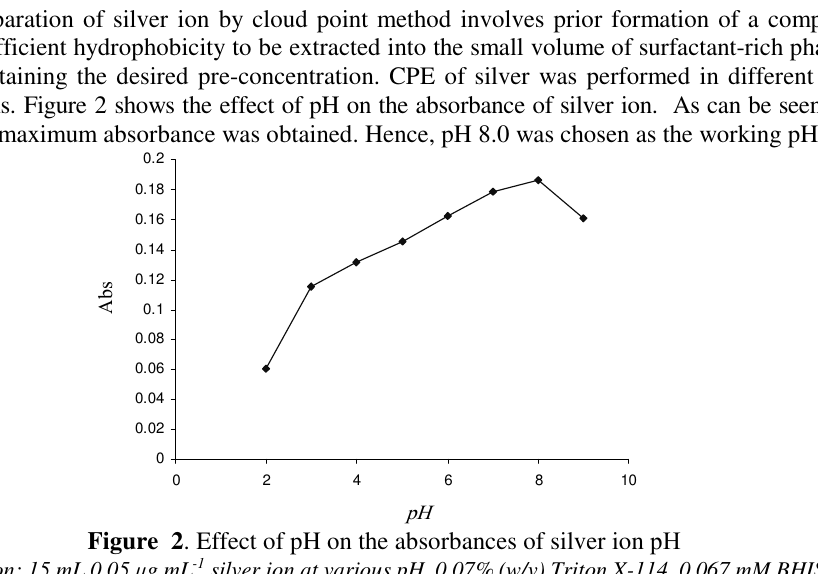
C ondition: 15 mL 0.05 µ g mL -1 silver ion at various pH, 0.07% (w/v) Triton X-114, 0.067 mM